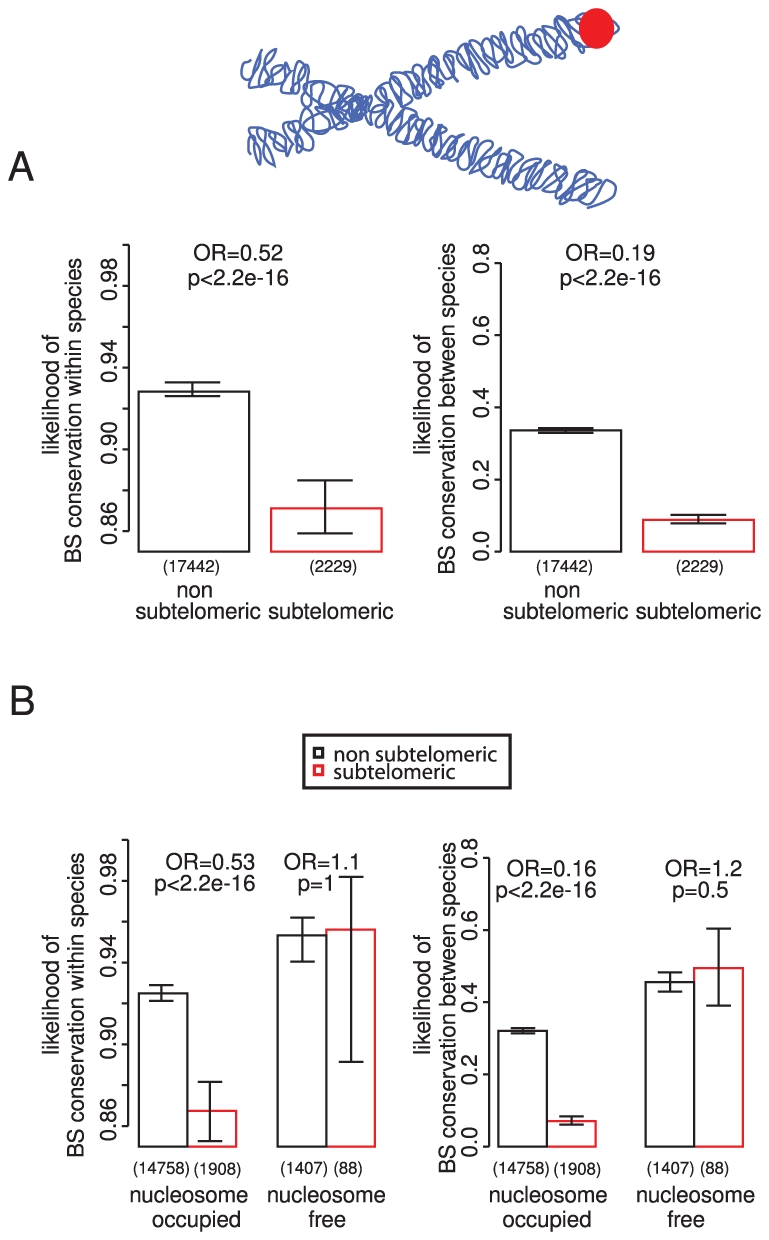
TF binding sites in subtelomeric regions and nucleosome-free regions.TF binding sites in subtelomeric regions (<40 kb from chromosome ends) are less conserved within and between species (A). However binding sites in nucleosome-free regions are similarly conserved in subtelomeric regions and in the rest of the genome (B).